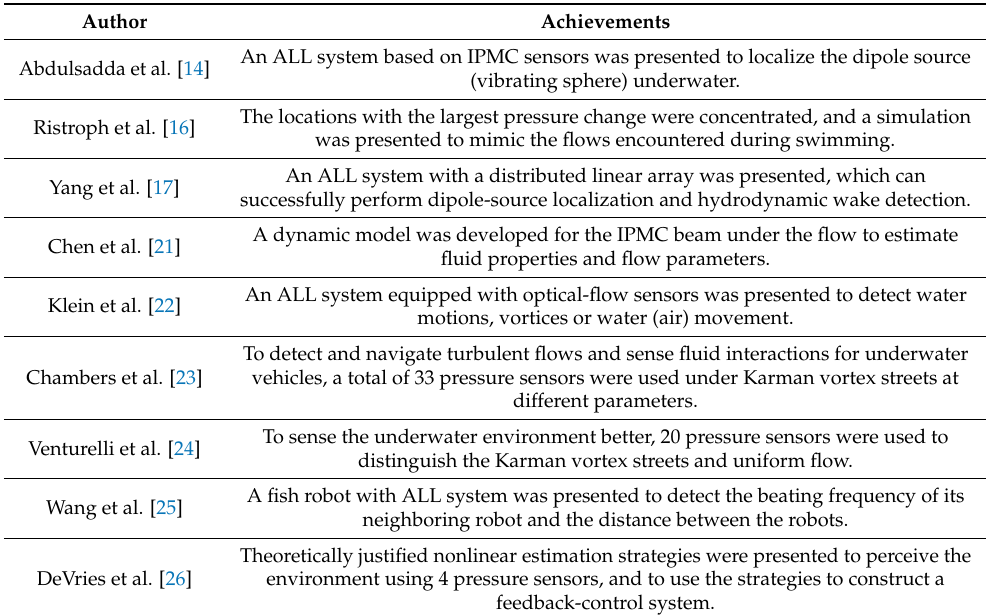
Table 1. Previous works about artificial lateral